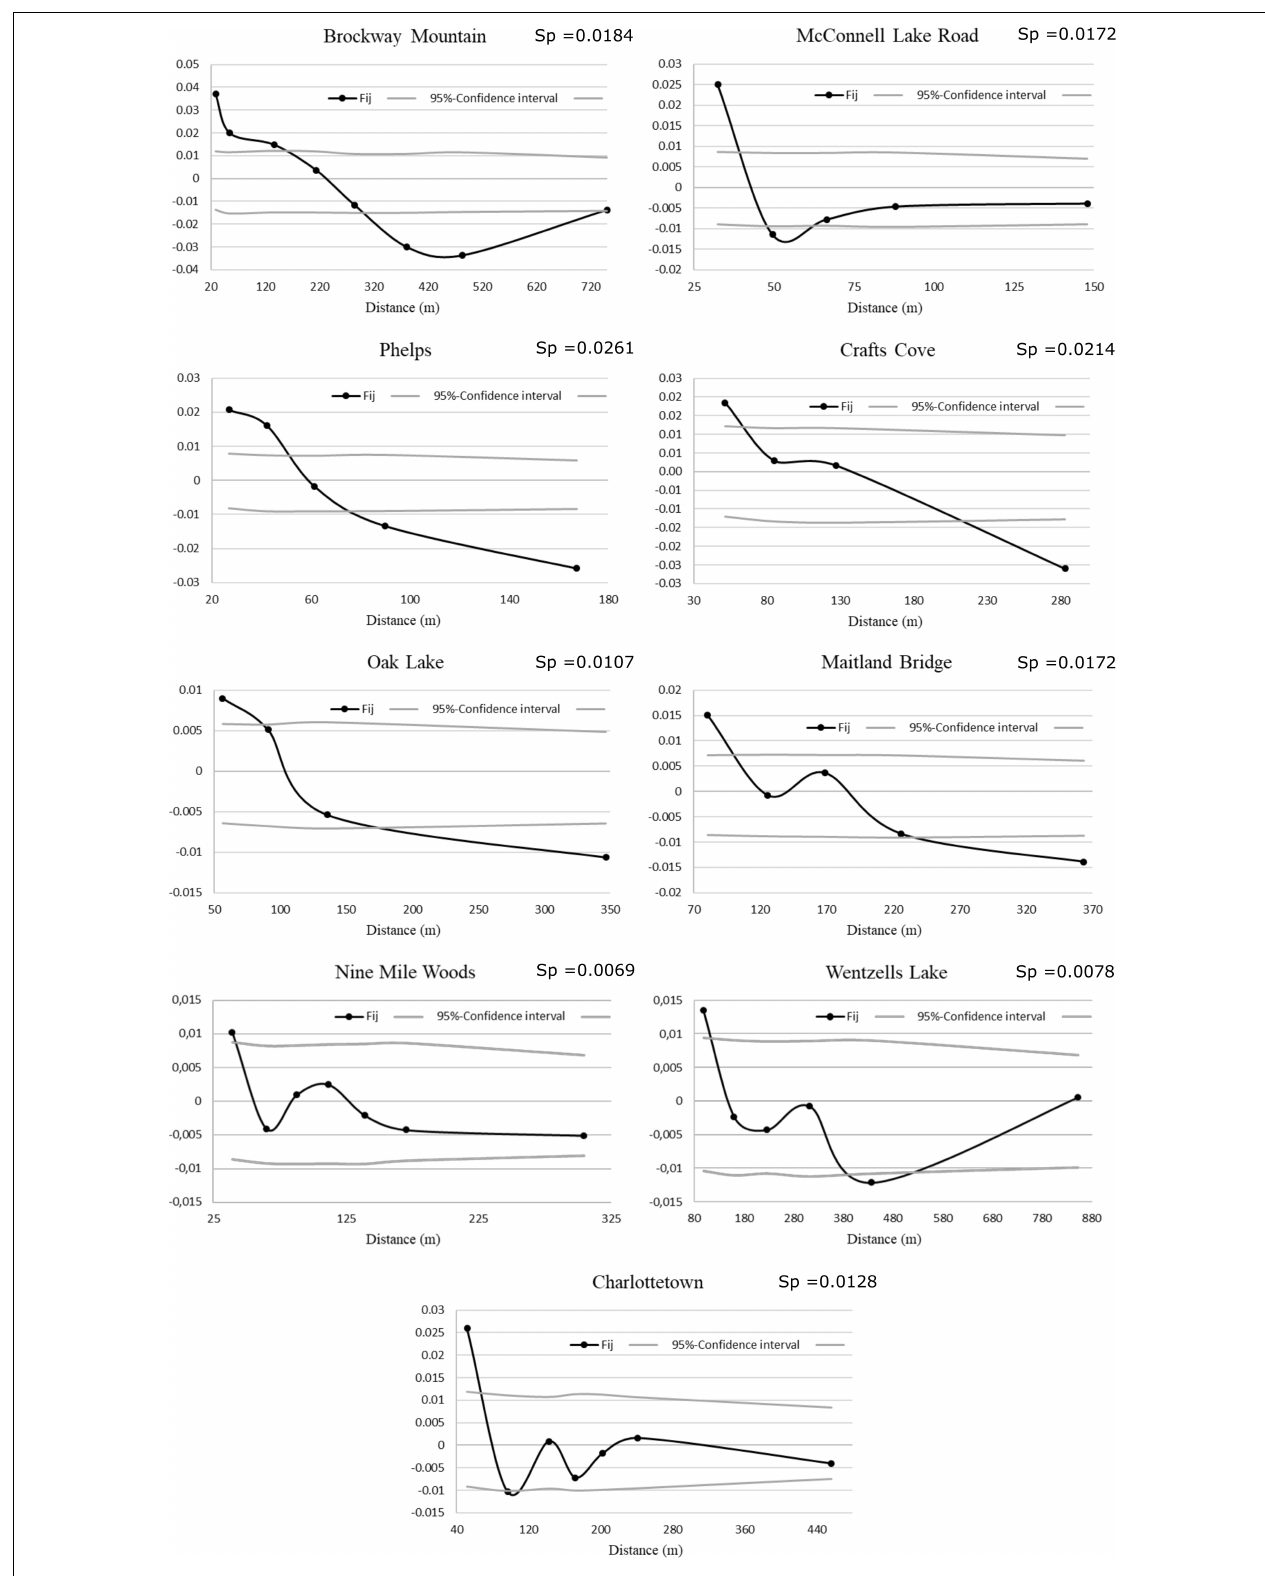
FIGURE 3 | Kinship coefficient ( F ij ), 95% confidence intervals (grey lines), and Sp values, representing the spatial genetic structure within nine northern red oak populations.